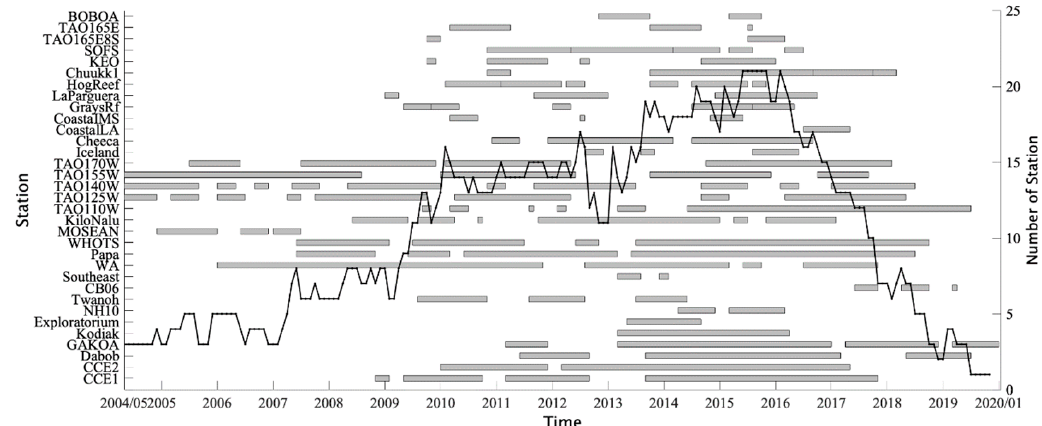
Figure 3. Time series of global buoy data. The right axis shows the number of stations corresponding to a given time. The horizontal bars represent the data available at the corresponding site at different times.